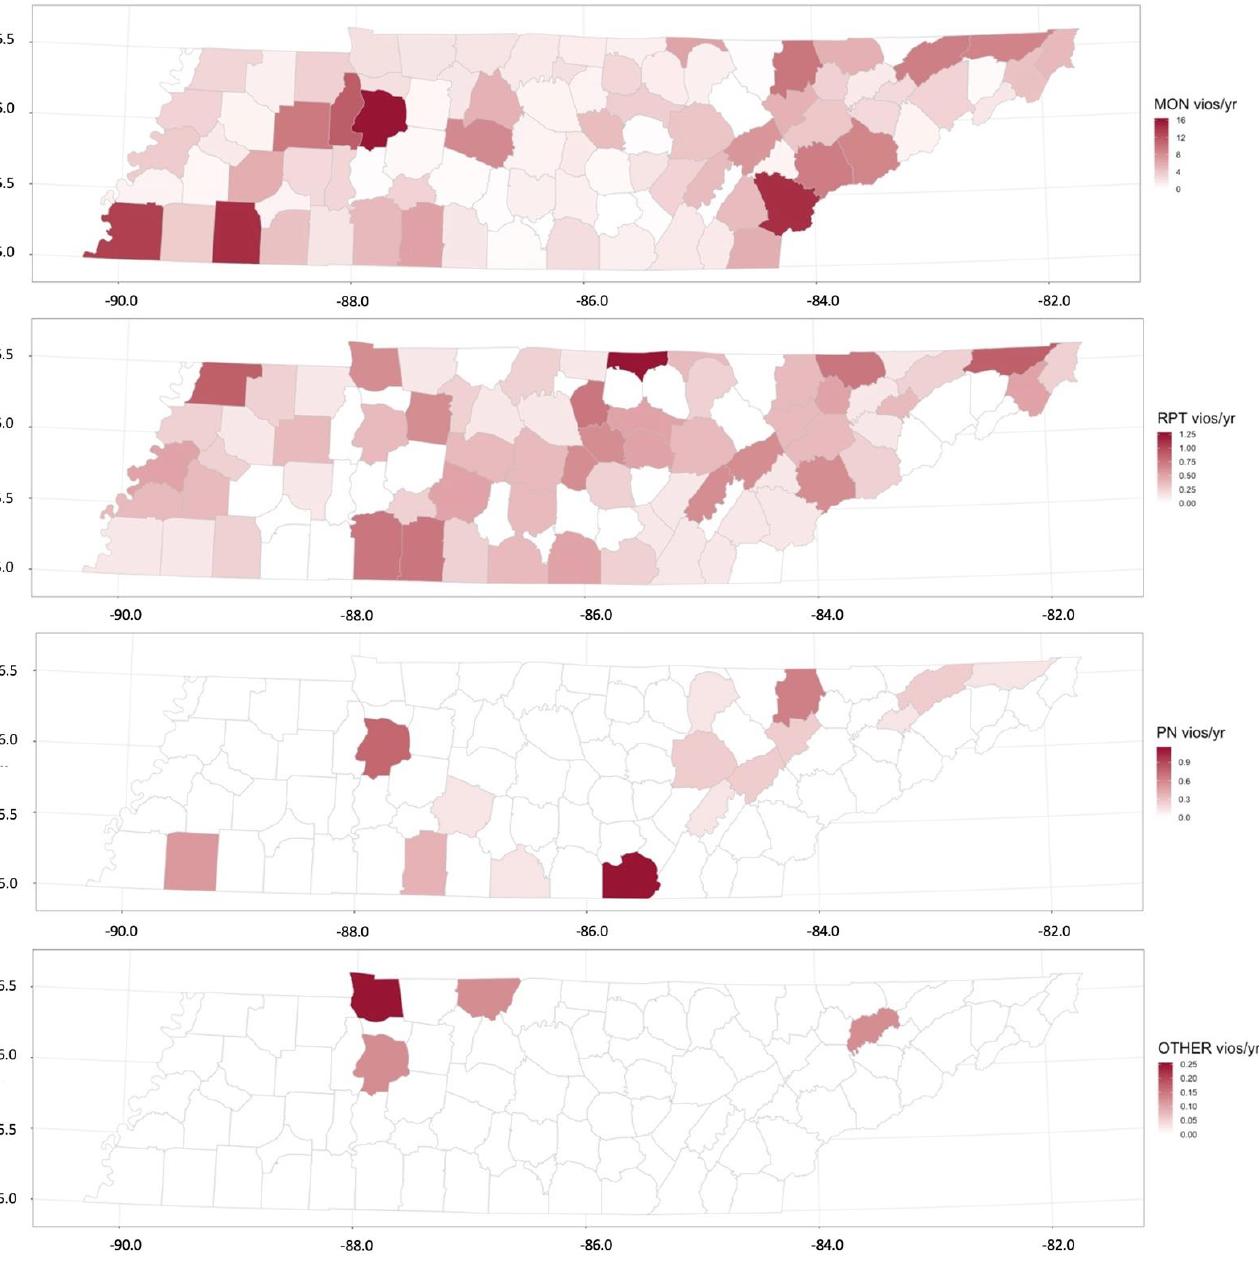
Figure 8. Maps of monitoring (MON) violations, reporting (RPT) violations, Public Notice (PN) violations, and other (OTHER) violations per county per year. The x axis is longitude, the y axis is latitude.